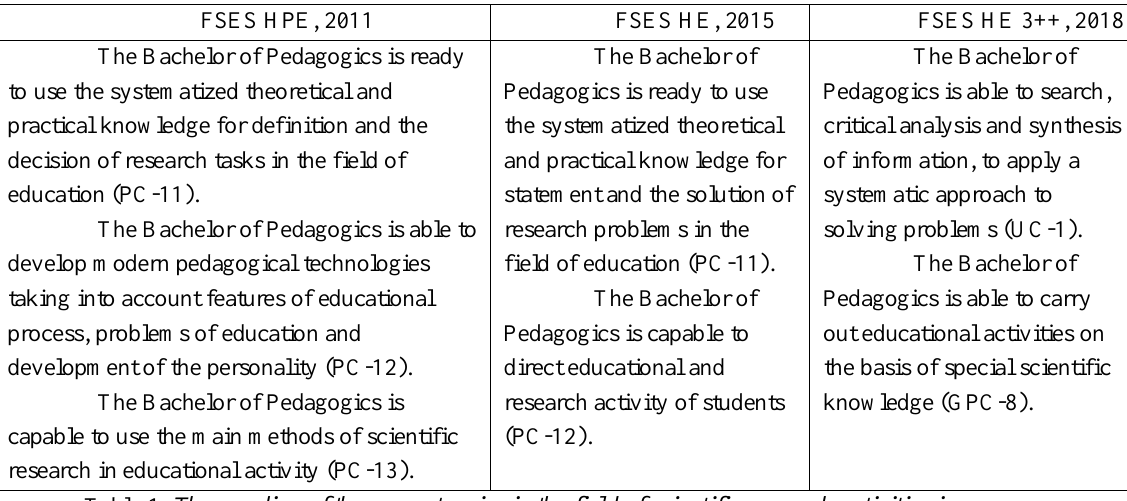
Table 1. The wording of the competencies in the field of scientific research activities